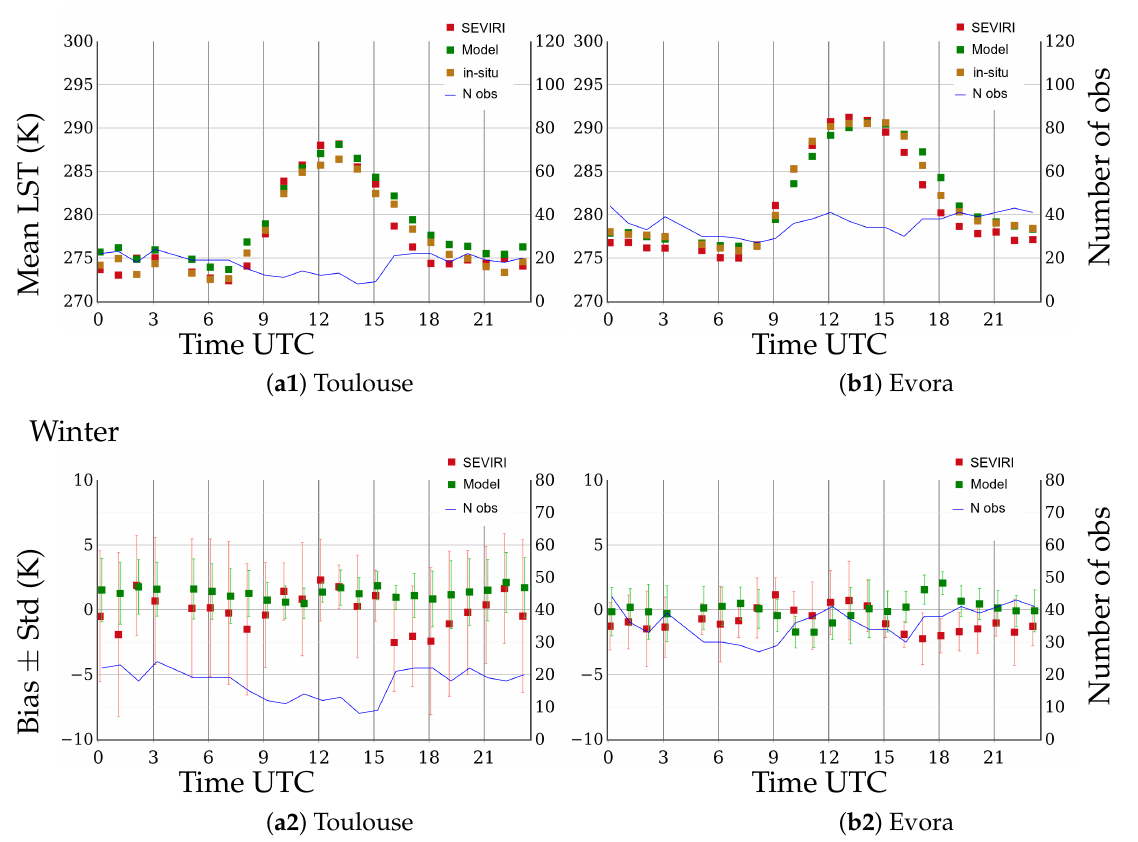
Figure 4. Diurnal variability of surface mean temperature (K) from SEVIRI (Red), model 1 h forecast (Green) and local observation (Brown) during winter period (January & February 2018) for Toulouse station ( a1 ) and Evora station ( b1 ) and statistics of differences of SEVIRI LSTs (Red) and Model LSTs (Green) minus observation for Toulouse station ( a2 ) and Evora station ( b2 ): the markers describe the bias while the bars describe the associated standard deviation. The blue line shows the number of SEVIRI/model LST used